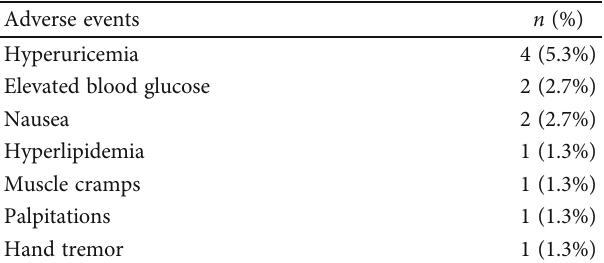
Table 2: Adverse events during tacrolimus